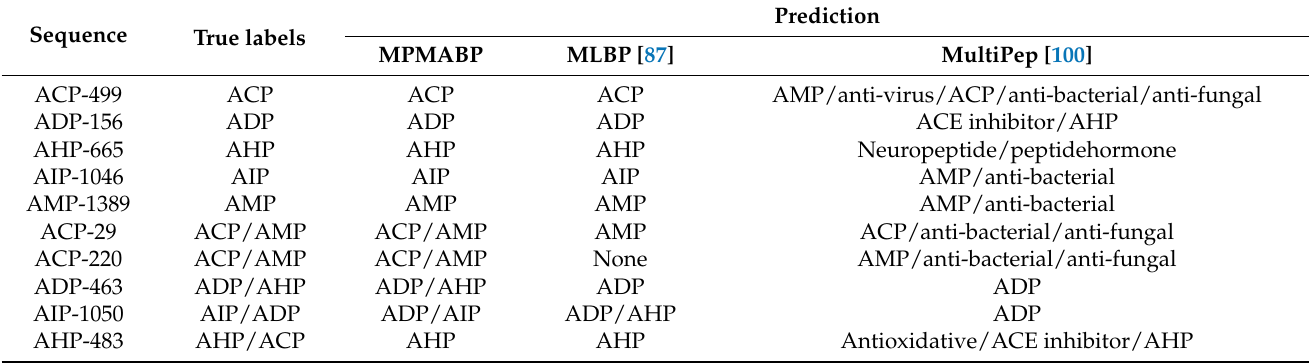
Table 5. Comparison of MPMABP with two other algorithms by case